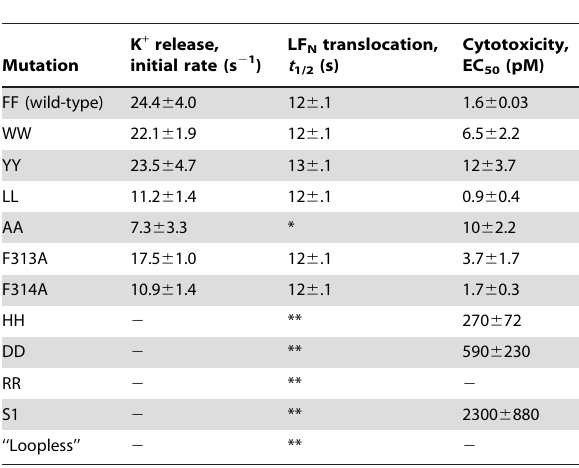
Table 1. Pore formation, LF N translocation and LF N -DTA- dependent cytotoxicity mediated by F313X/F314X mutants.